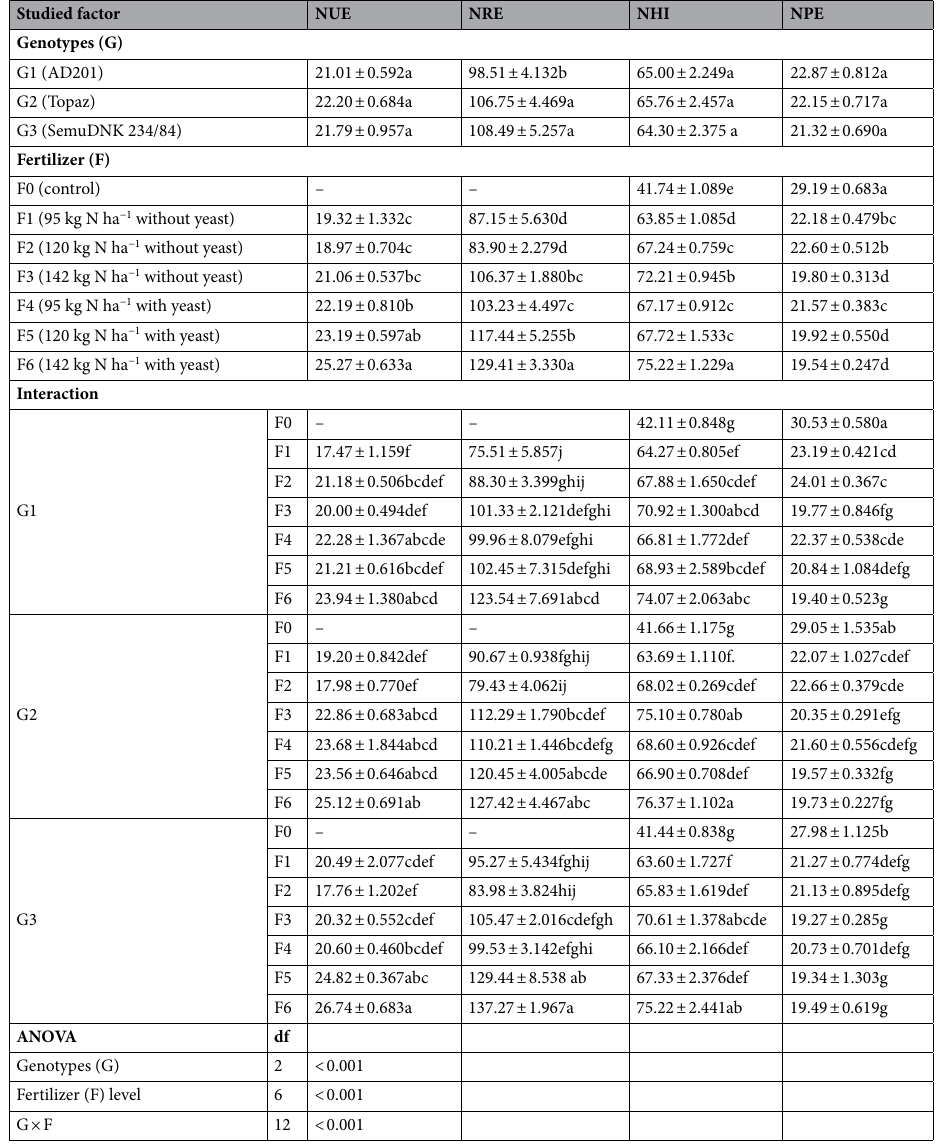
Table 6. Nitrogen efficiency indexes for three Canola genotypes under different N applications without and with yeast